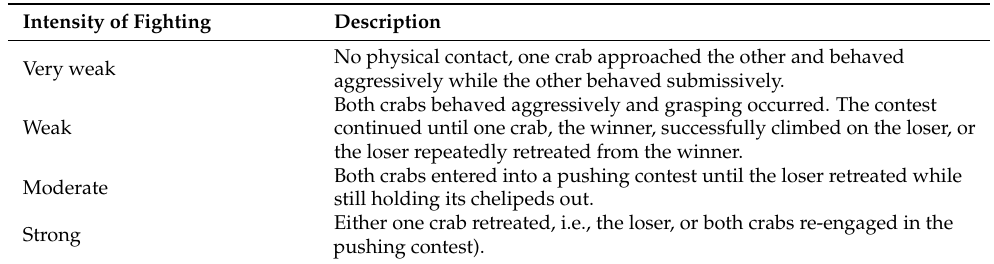
Table 1. Fighting intensity description of swimming crabs.